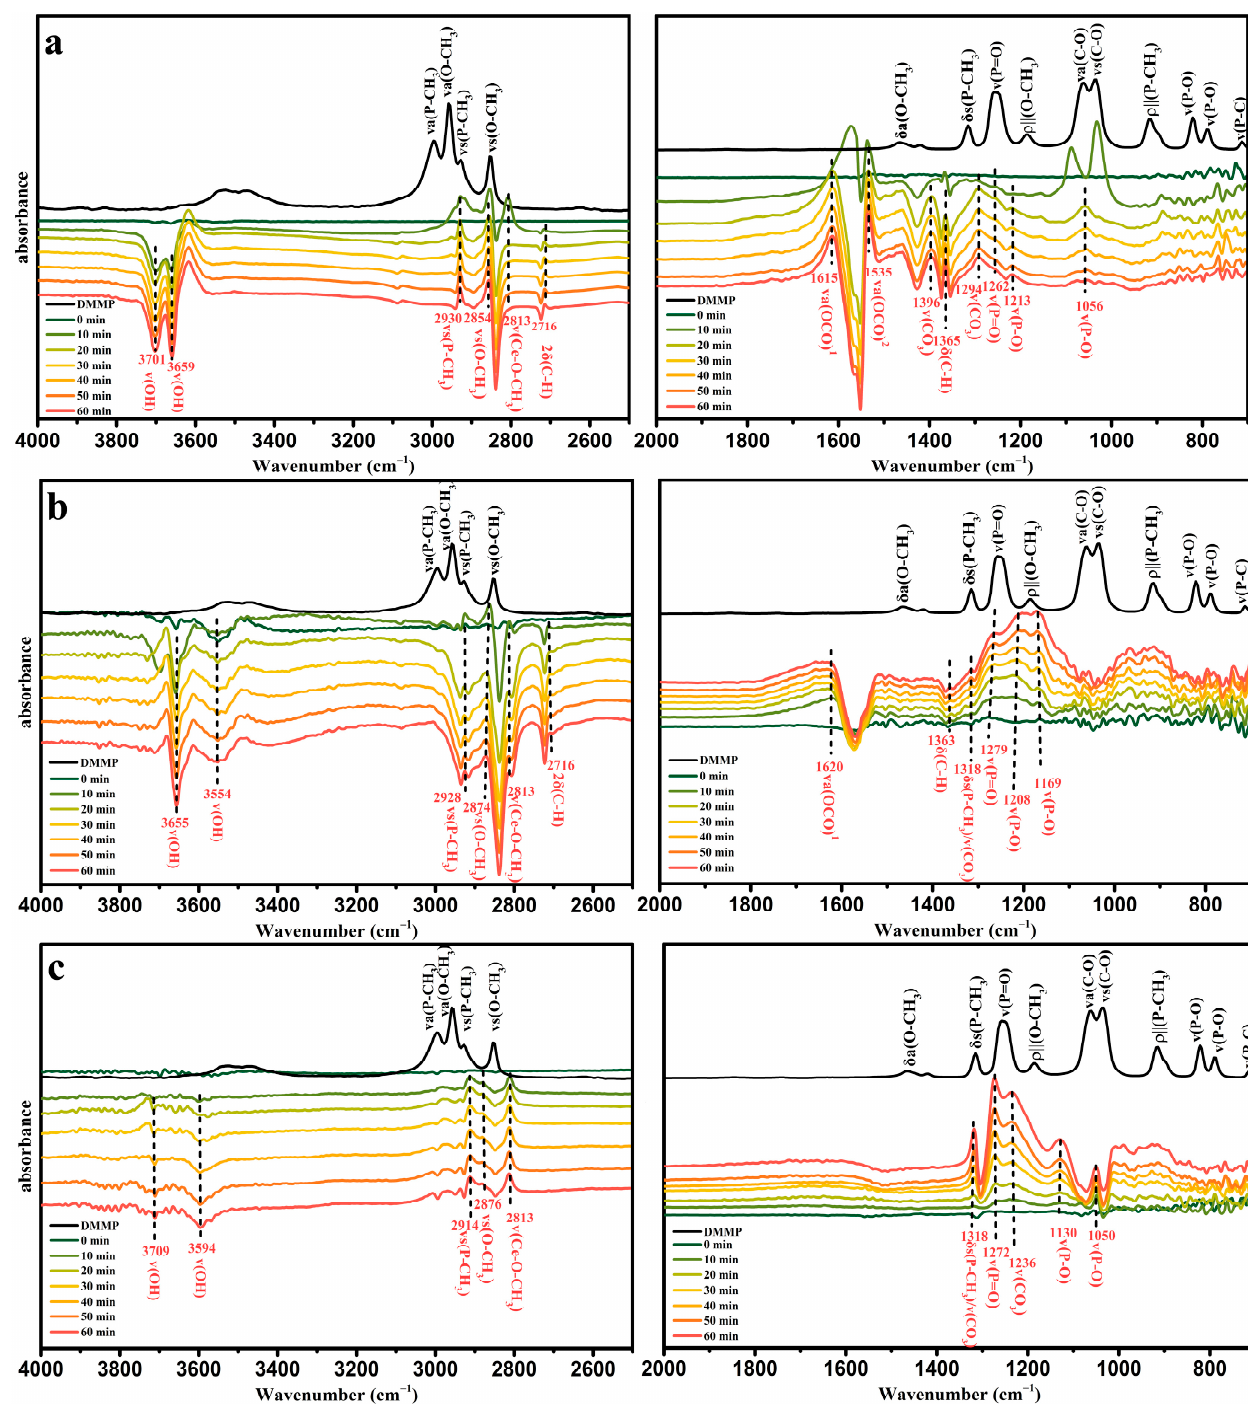
Figure 10. In situ DRIFTS spectra of CeO 2 nanomaterials ( a ) 2MCeO 2 np, ( b ) 12MCeO 2 nr, and ( c ) 12MCeO 2 nc. Table 6. Assignments of IR frequencies in DMMP.